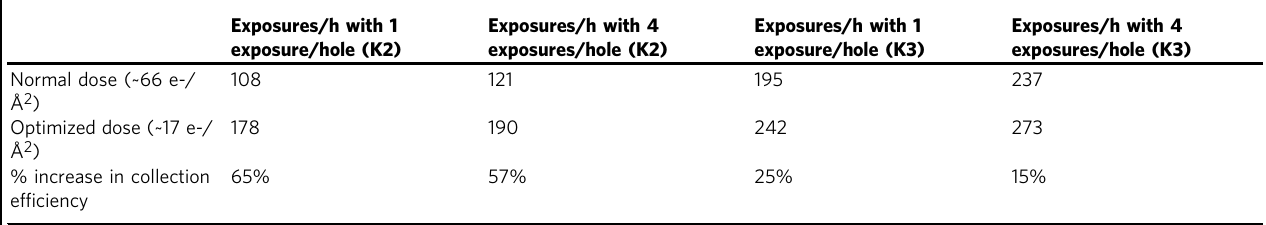
Table 2 Comparison between normal dose exposures versus optimized dose exposures using typical high-resolution microscope systems and